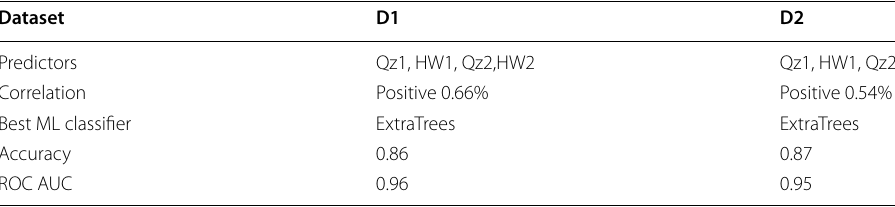
Table 4 Performance of classification models in predicting students’ groups from checkpoints before the midterm exam (datasets D1 and